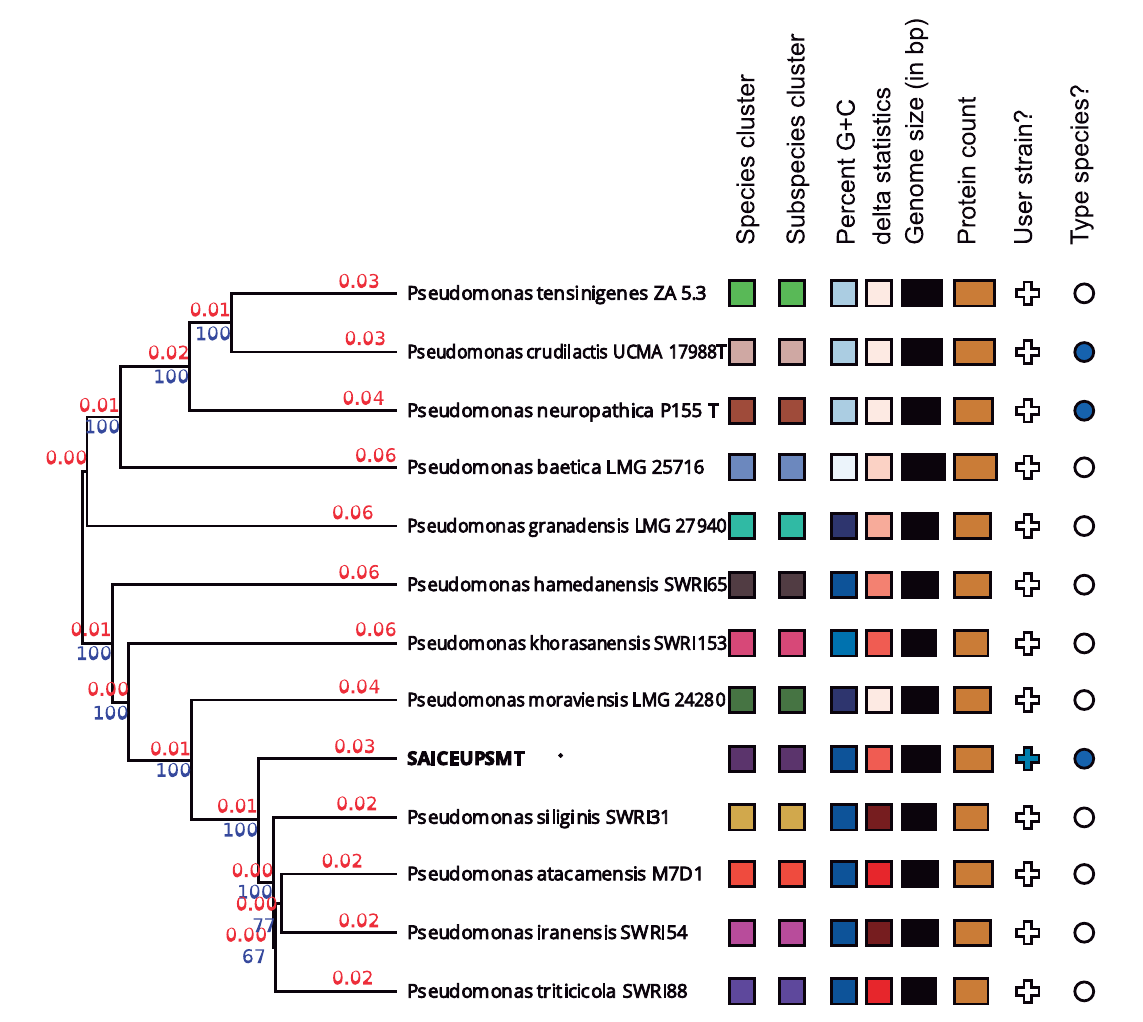
Calculated ANIb values, Supplementary Table 2 : Calculated Tetra values, and Supplementary Table 3 : Intergenomic